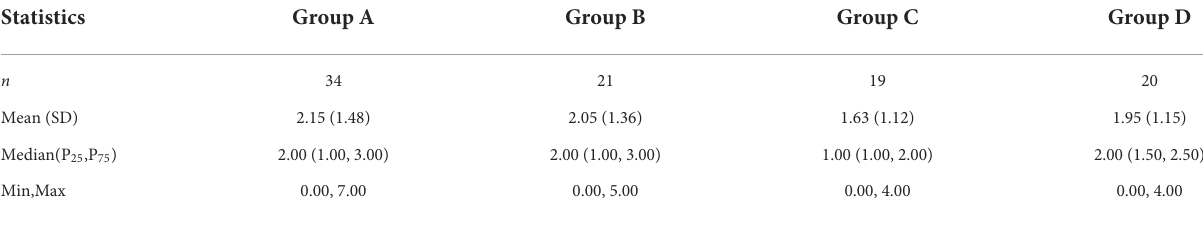
TABLE 4 Comparison of chronic tissue injury scores between groups before